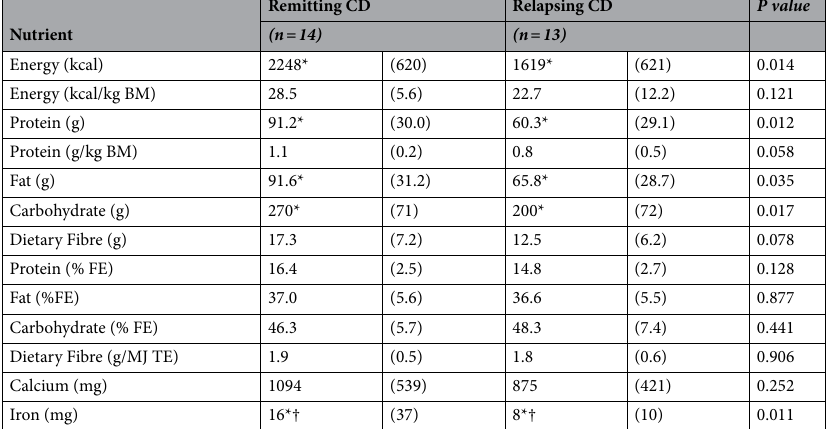
Table 3. Comparison of the reported mean daily intake (energy and nutrients) of participants in Crohn’s Disease relapse or remission. CD, Crohn’s disease; BM, body mass; MUFA, monounsaturated fatty acids; PUFA, polyunsaturated fatty acids; FE, food energy; TE, total energy. * p < 0.05; † not normally distributed (Shapiro–Wilk p < 0.05). Remitting CD (n = 14, age 20–60y), relapsing CD (n = 13, age 29-73y). Data are presented as mean (SD) or median (IQR).